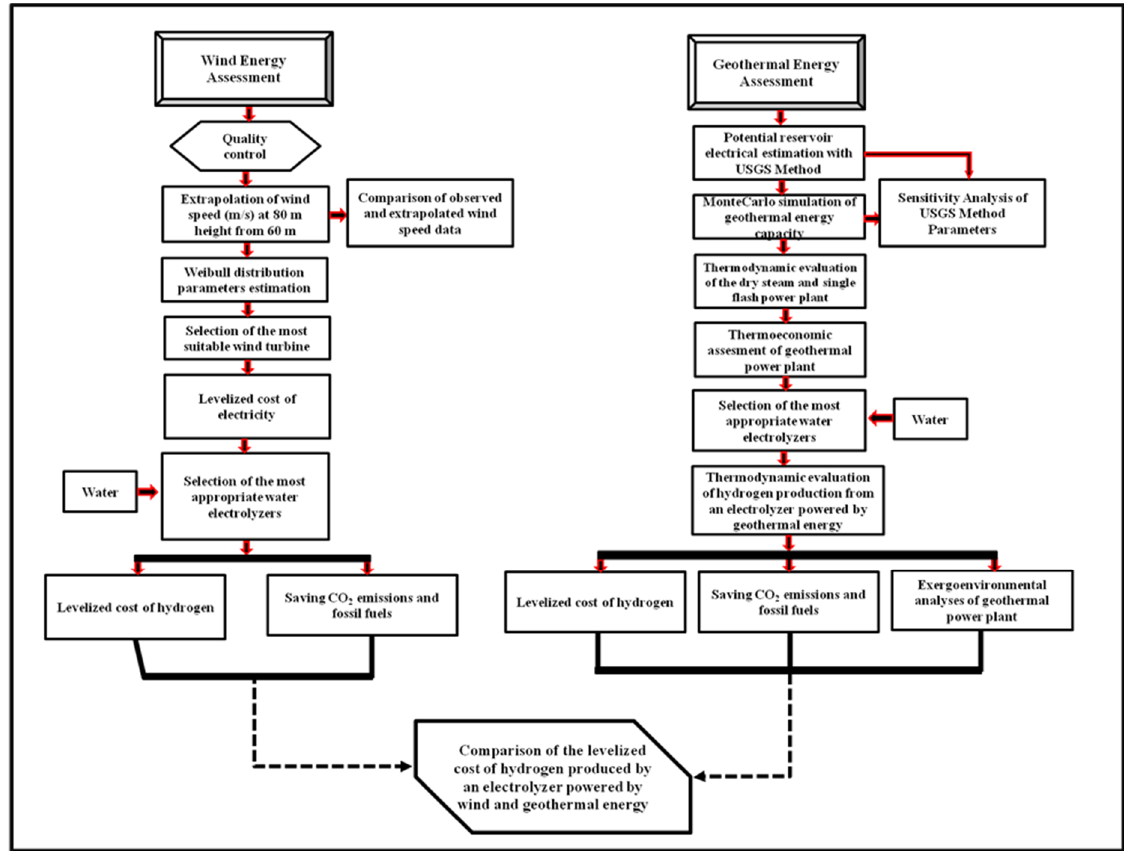
Figure 2. Methodology schematic diagram.